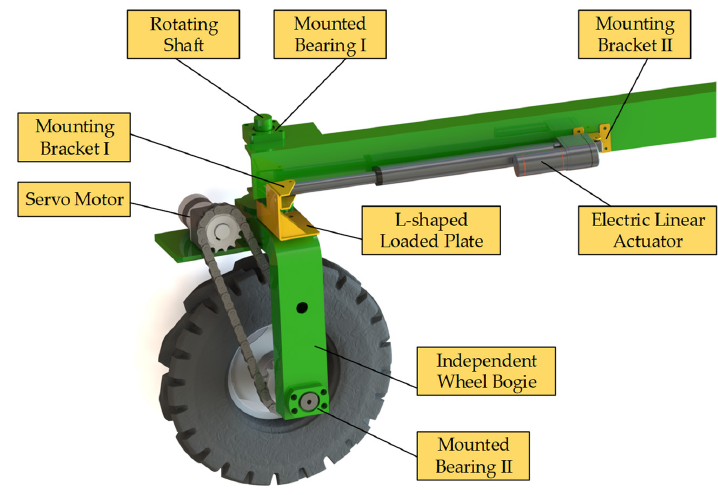
Figure 1. Wheel independent omnidirectional steering mechanism.